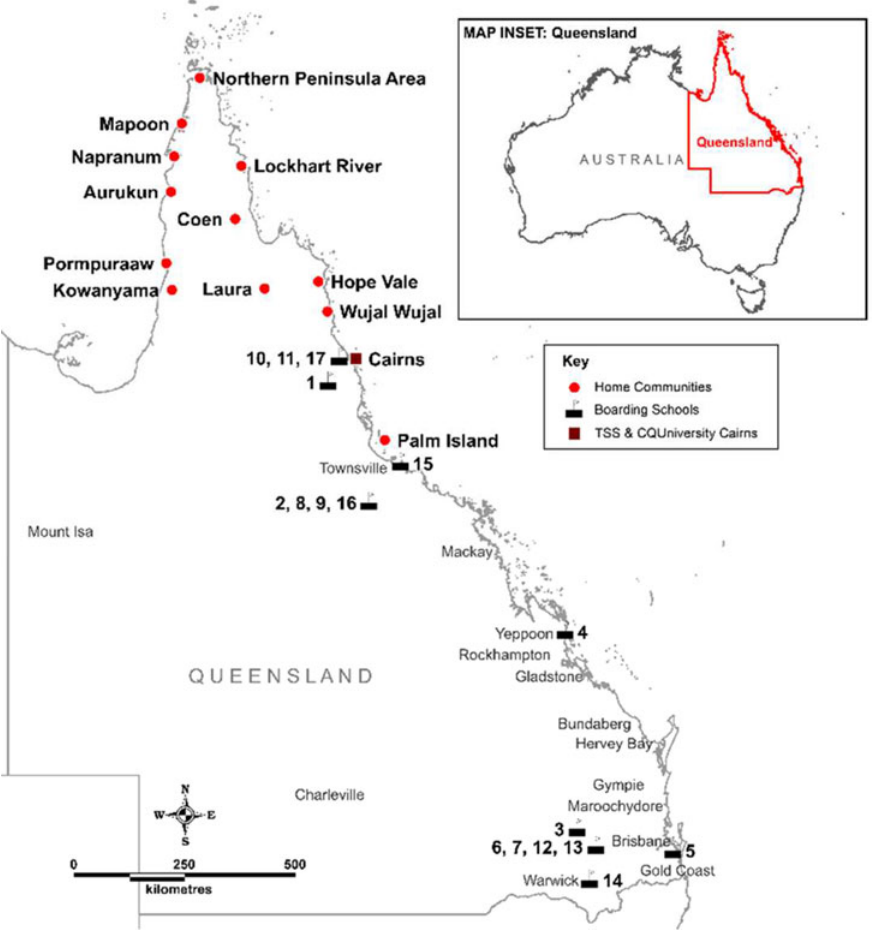
Fig. 1. Map of student ’ s home communities and destination boarding schools (Kelly,